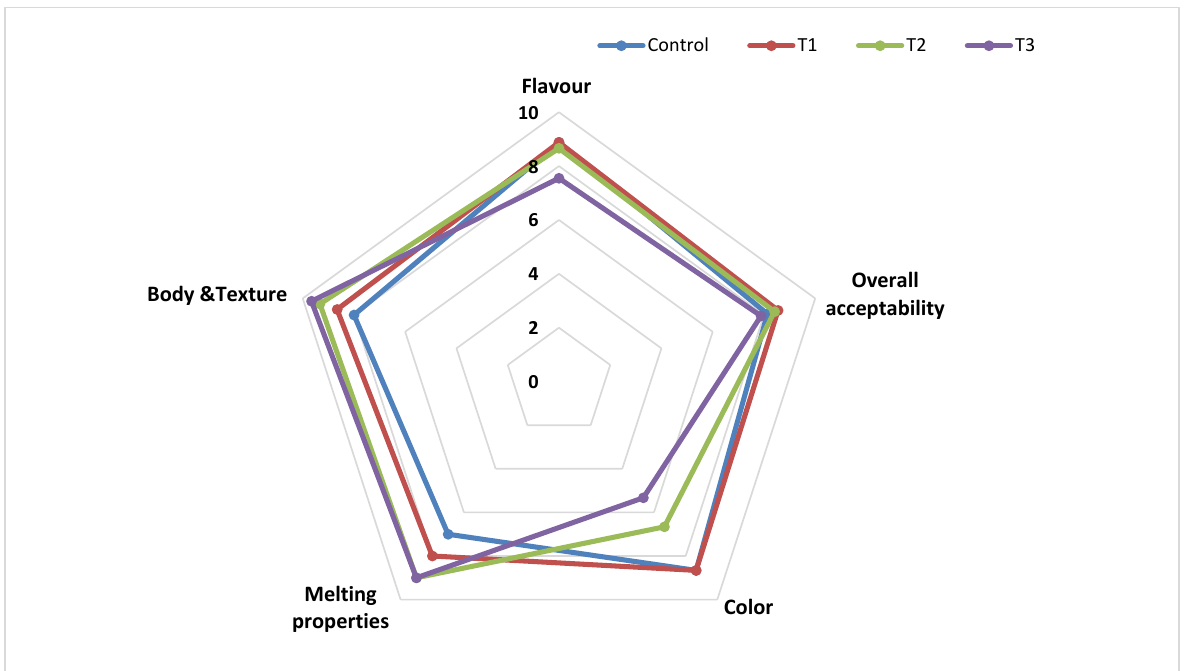
Figure 3. Sensory evaluations of ice cream samples. Control: ice cream made without any replace- ments. T1: ice cream made by replacing 25% of skim milk powder with BRP. T2: 50% replacements of skim milk powder with BRP. T3: 75% replacements of skim milk powder with BRP. Values represent the mean ± SE; n = 15.